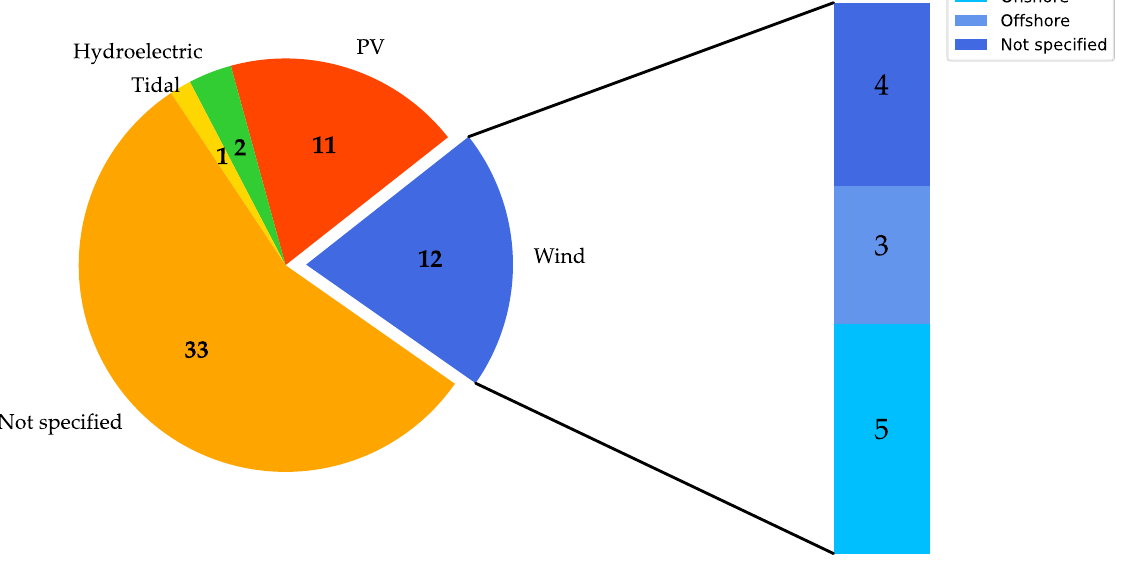
Figure 14. Number of projects per renewable electricity source.